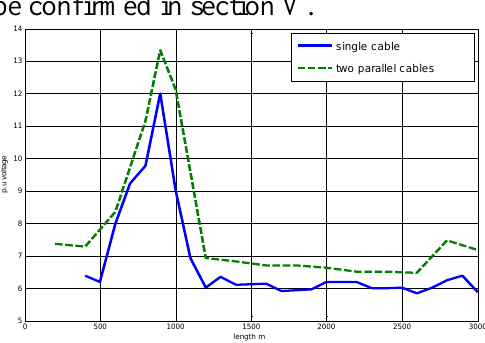
Fig. 7. Maximum instantaneous overvoltage for phase-c secondary against cable